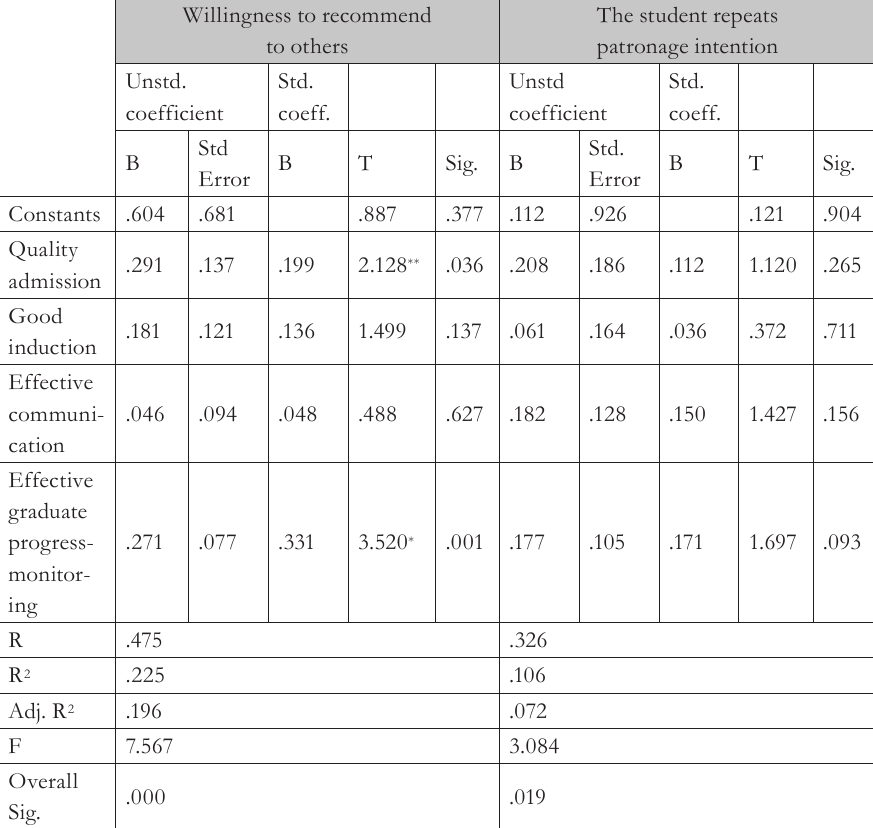
Tab. 1 - Regression effects of student life cycle management on students’ willingness to recom- mend their universities to others and student repeat patronage intention. Source: Field Survey,